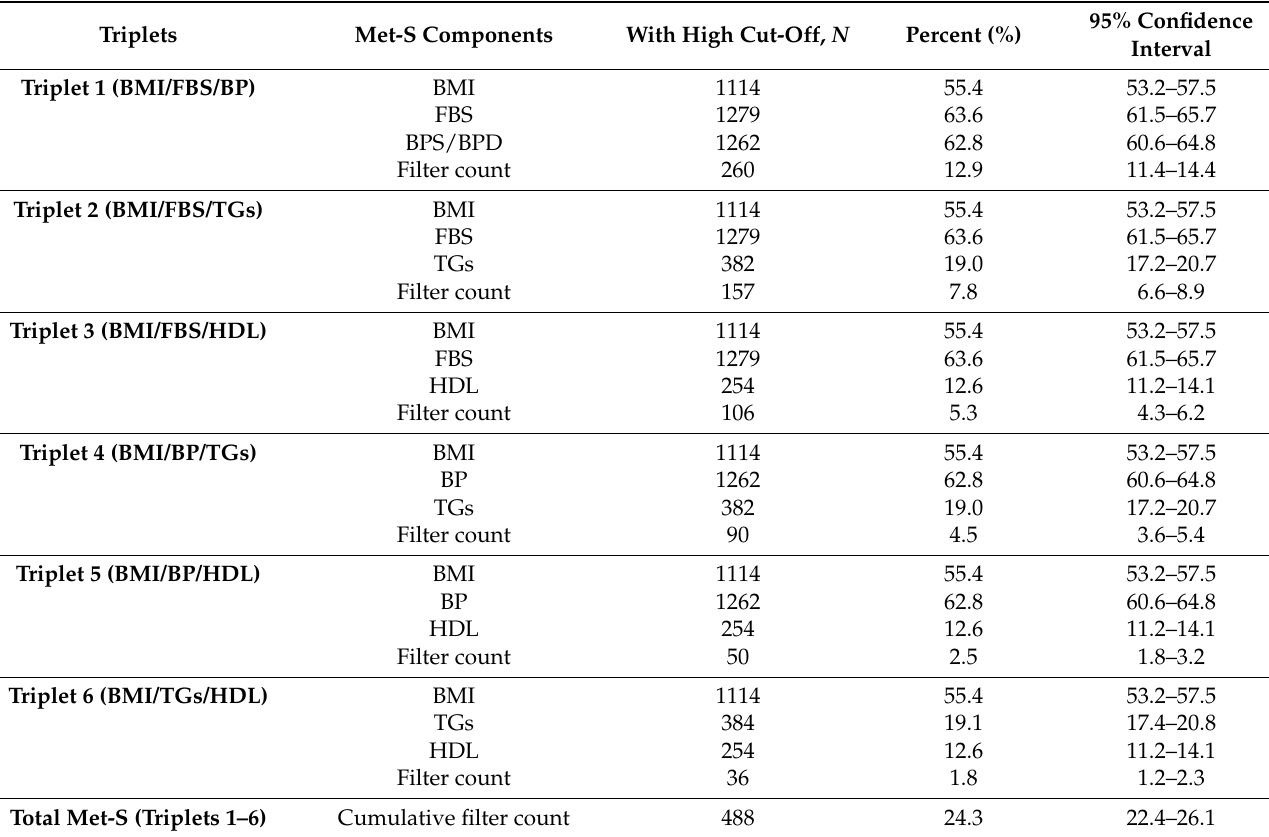
Table 7. Diagnosis of Met-S using the triplets of Met-S component